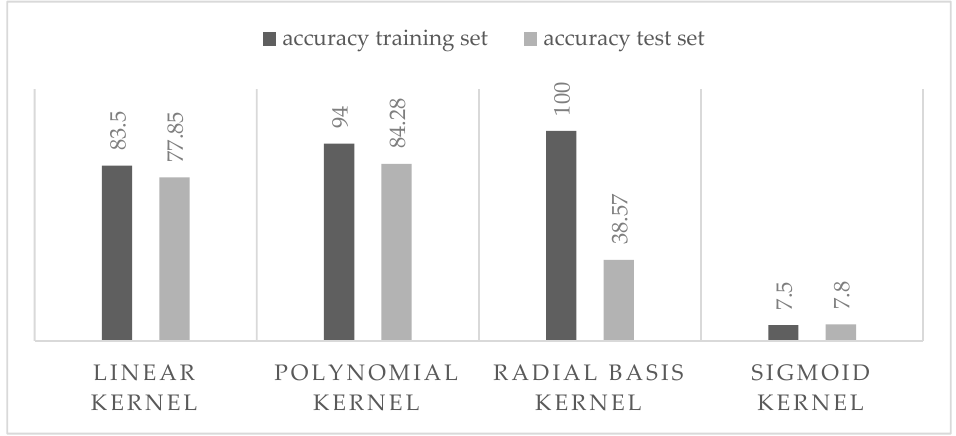
Figure 10. Comparison between different kernel functions for support vector machine (SVM) training with respect to accuracy on the training data set and test data set.